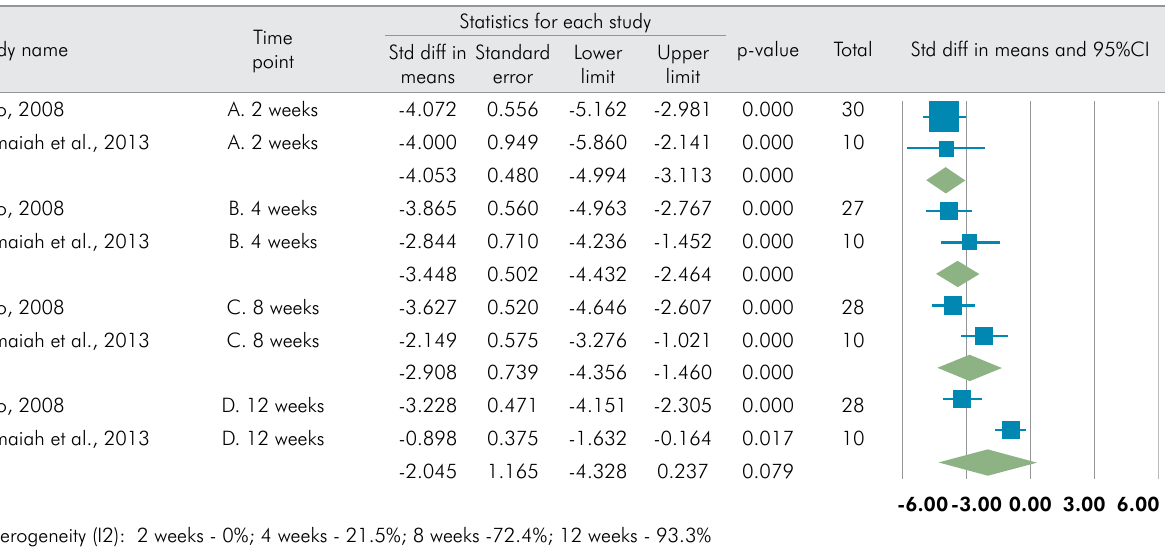
Figure 3. Comparisons of gingival display between baseline and at 2, 4, 8, and 12 weeks of treatment. A: Data are presented in millimeters; B: Comparison using standard